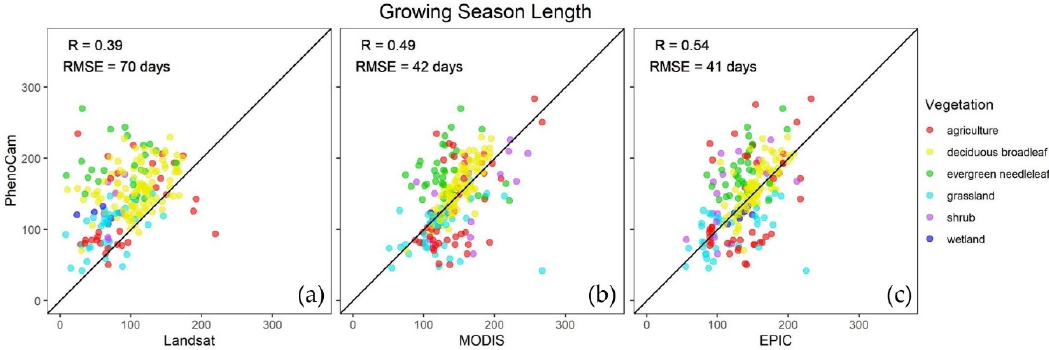
Figure 9. The correlation between Growing Season Length (GSL) (in days) for PhenoCam and ( a ) Landsat, ( b ) MODIS, and ( c ) EPIC over 2016–2018. Landsat, ( b ) MODIS, and ( c ) EPIC over